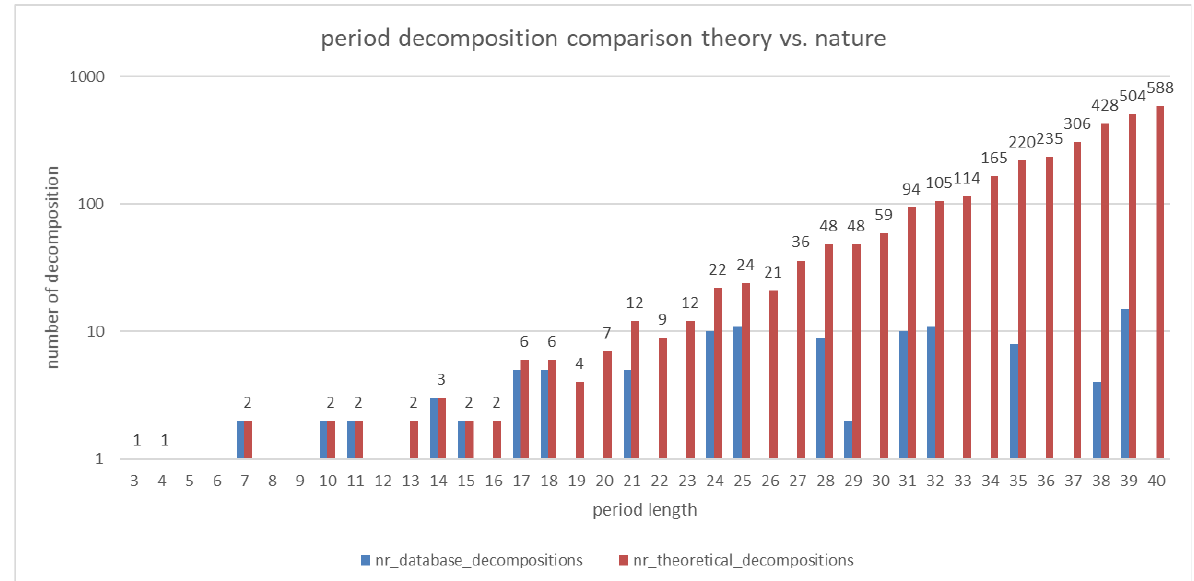
Figure 1. Comparison of the number of theoretically possible decompositions (red) and decompositions found in dimeric coiled coils listed in the CC+-database (blue) for period lengths between 3 to 40. Be aware that the y-axis (number of decompositions) is log-transformed.